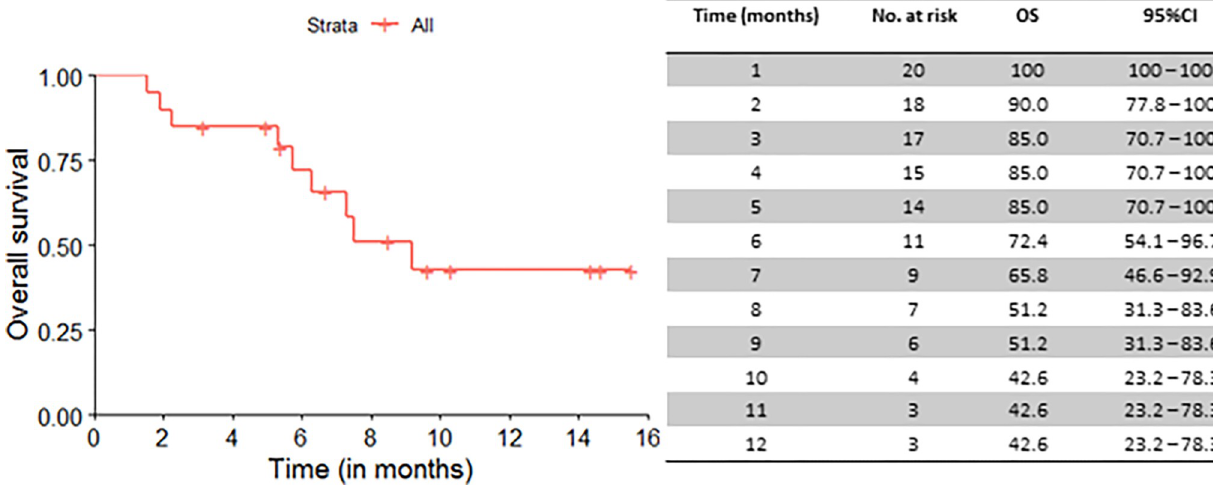
Fig 1. Overall survival curve for all patients (n = 20). Median OS (months): 9.2 (95%CI: 6.3 to not reached).